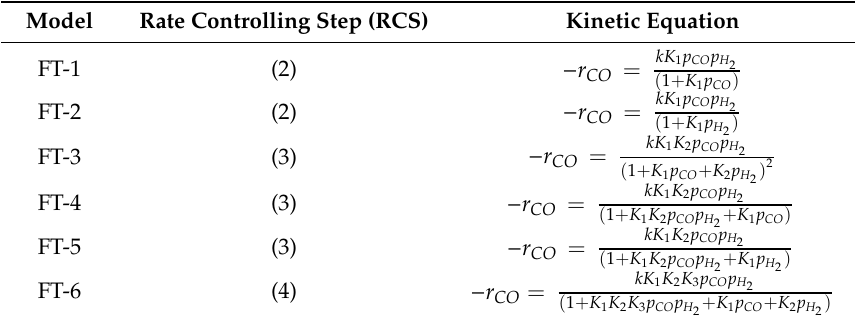
Table 3. Proposed kinetic equations for Fischer–Tropsch